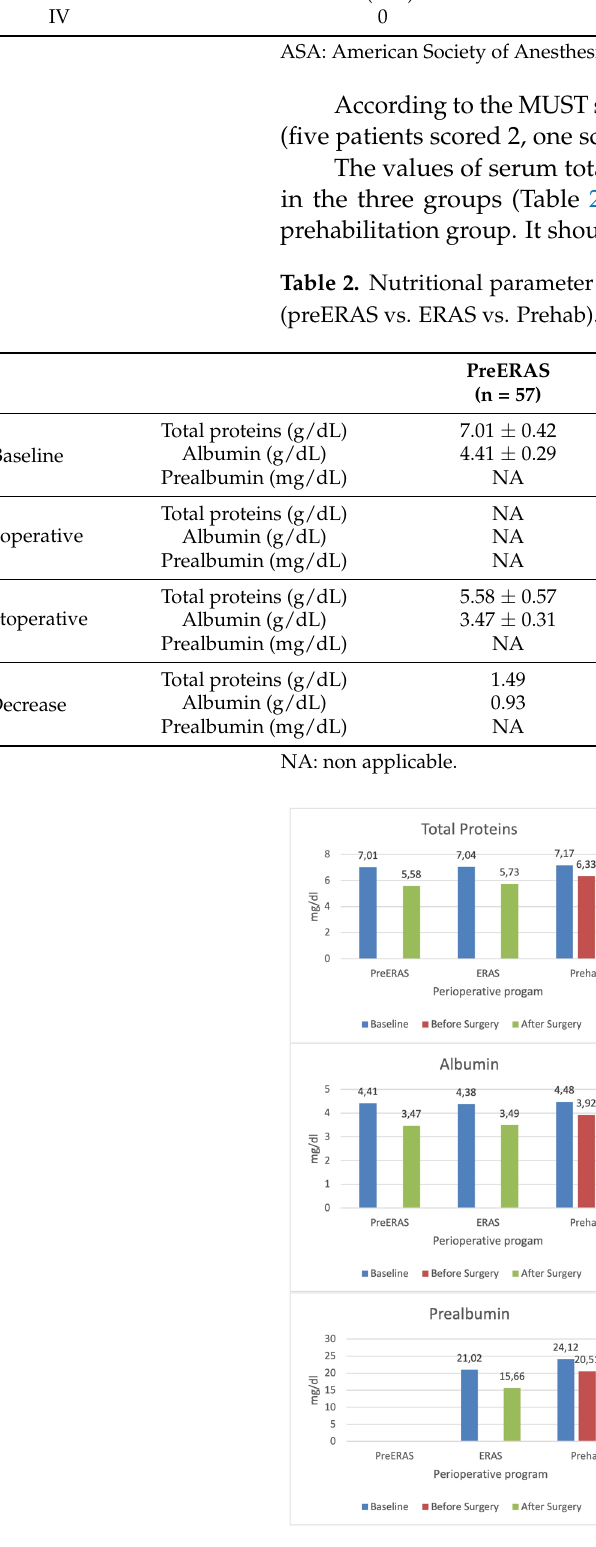
Figure 1. Variation of serum levels according to intervention groups.